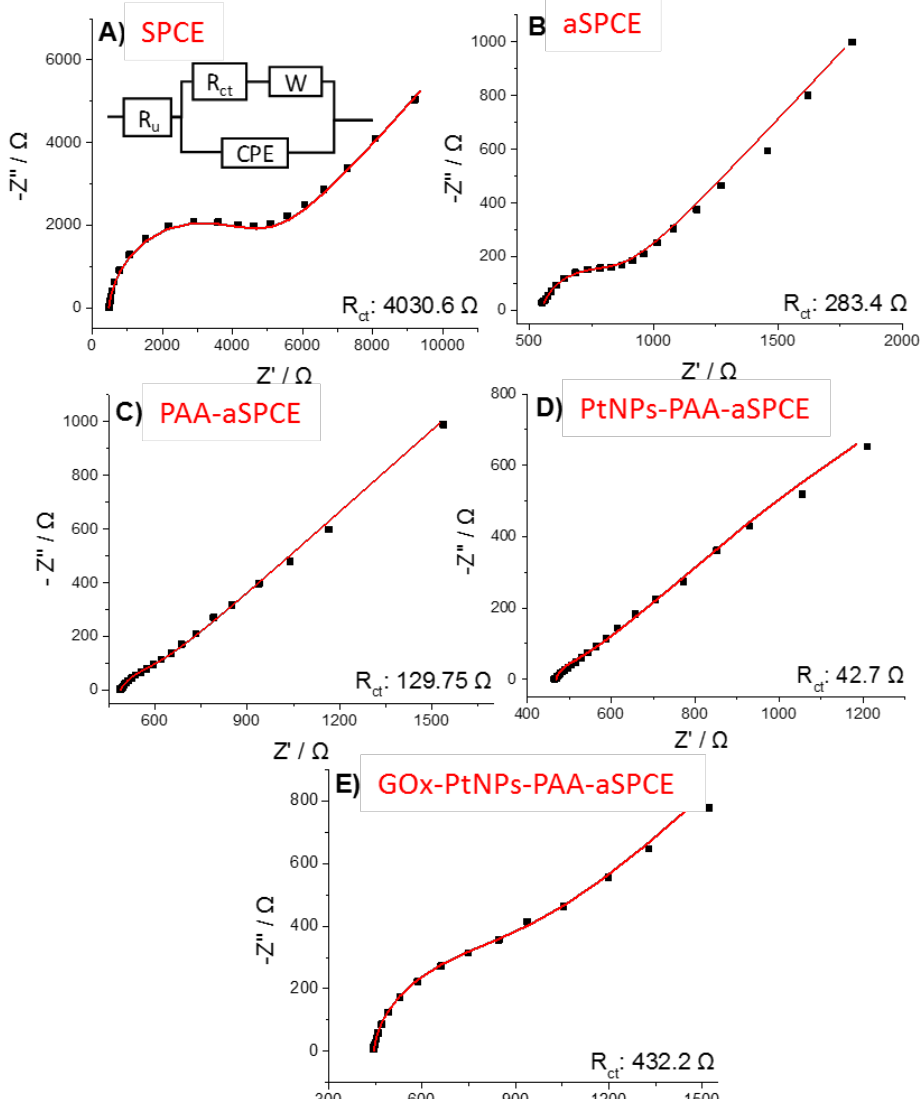
Figure 3. Nyquist plots for the different steps of the working electrode modification: ( A ) SPCE, ( B ) aSPCE, ( C ) PAA-aSPCE, ( D ) PtNPs-PAA-aSPCE and ( E ) GOx-PtNPs-PAA-aSPCE. Electrochemical impedance spectroscopy (EIS) was recorded at 0.15 V (vs. Ag) in 1 mM Na 4 Fe(CN) 6 (in 0.1 M KCl). Experimental conditions: stabilization time 60 s, amplitude 5 mV, and frequencies 65 kHz–10 mHz, with five points per decade. The inset in ( A ) shows the equivalent circuit used.